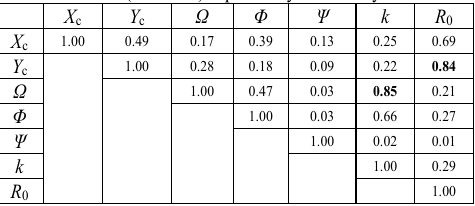
Table 10. Mean correlation matrix of octagonal cone model fitting with the real data (Pole 4 -5) captured by the Velodyne HDL-32E X c Y c